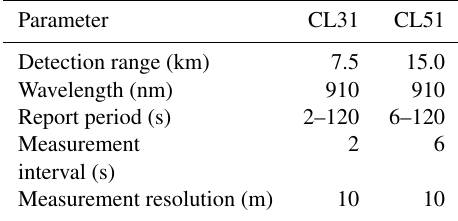
Table 1. Instrument properties of CL31 and